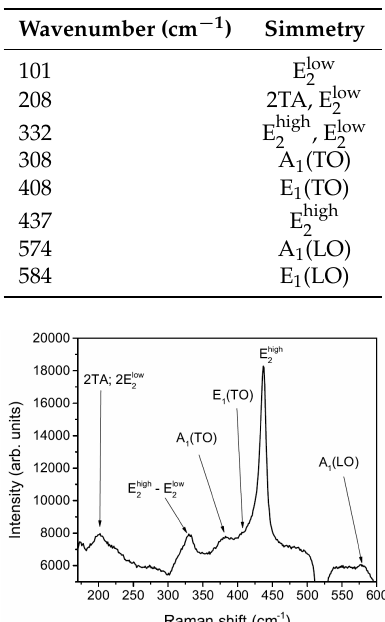
Table 2. Frequency and simmetry of the fundamental optical modes in wurtzite ZnO.